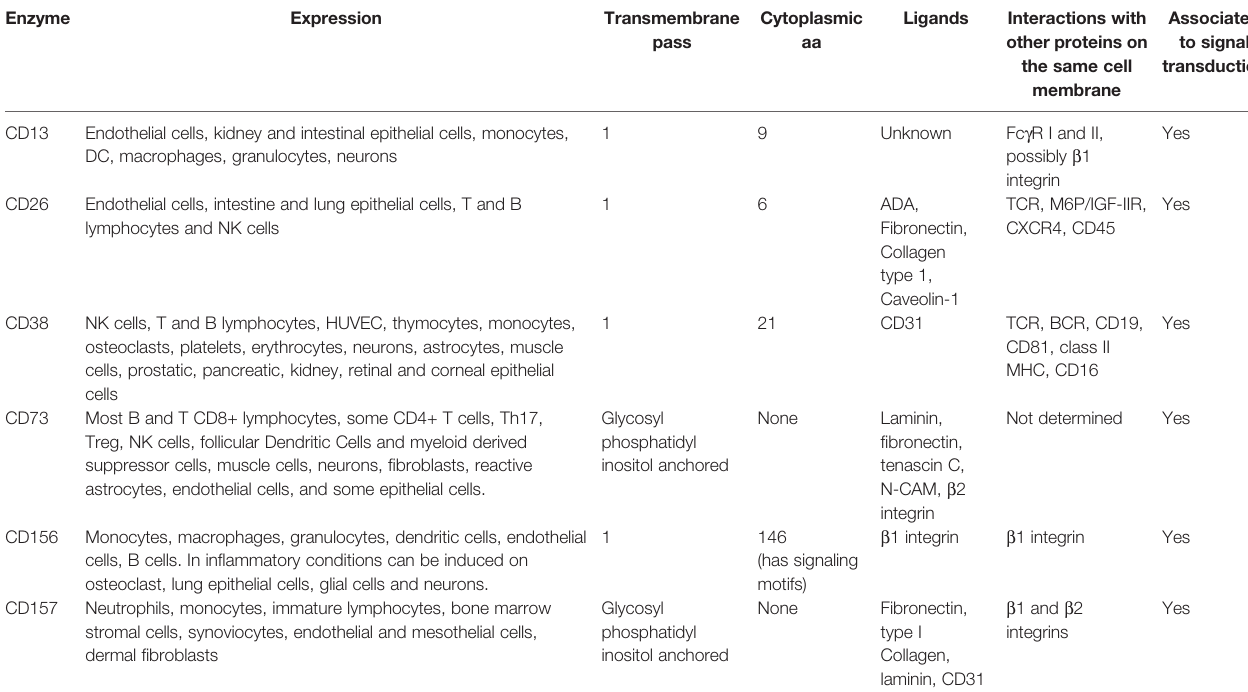
TABLE 1 | Expression and properties of the membrane enzymes that participate in cell adhesion in leukocytes.